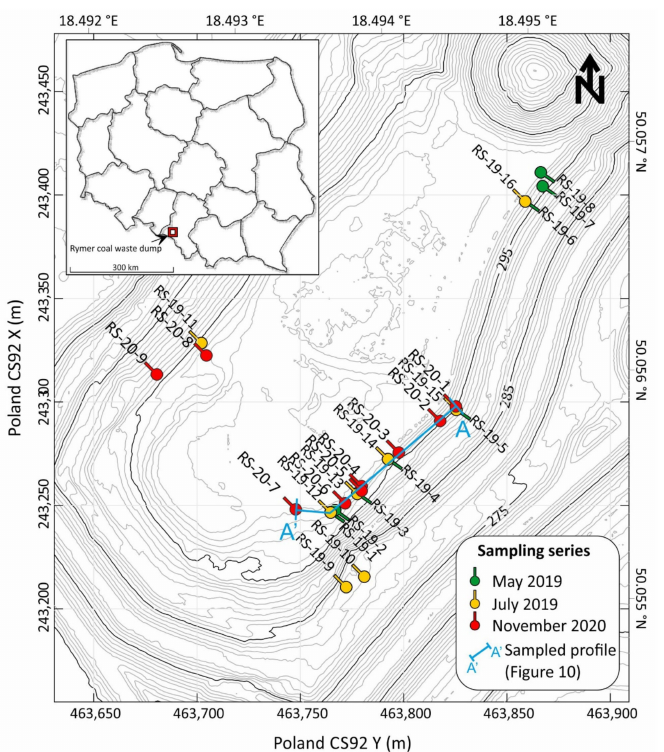
Figure 1. Location of gas and rock sampling sites on the background of the altimetry map of the Rymer coal waste dump. Poland CS92: The National Geodetic Coordinate System 1992 for Poland